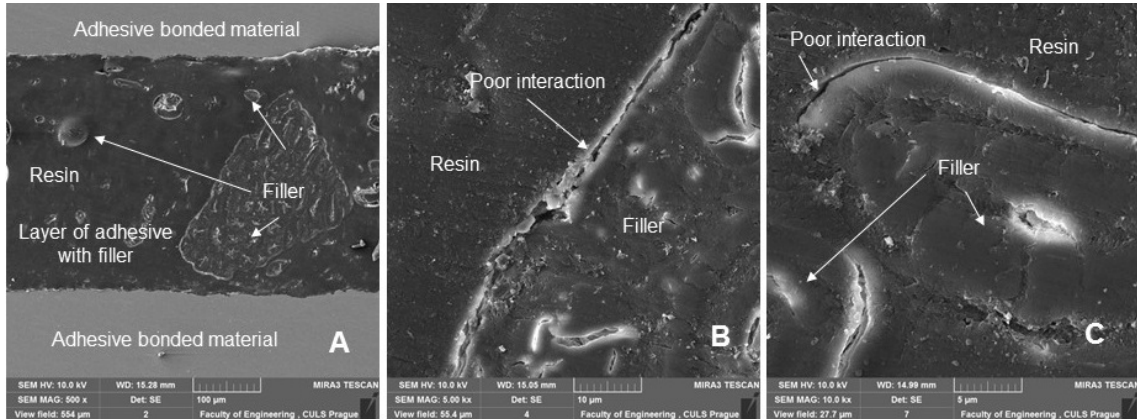
Figure 12. SEM images of an adhesive bond section with a biological filler based on coconut microparticles—designation AB10, quasi-static test from 5 to 30% (157–940 N), 1000 cycles: ( A ): adhesive bond section (MAG 500 ×), ( B ): section of the adhesive bond with a detailed view of the interaction of filler and resin (MAG 5.00 k×), ( C ): section of the adhesive bond with a detailed view of the interaction of filler and resin (MAG 10.00 k×).